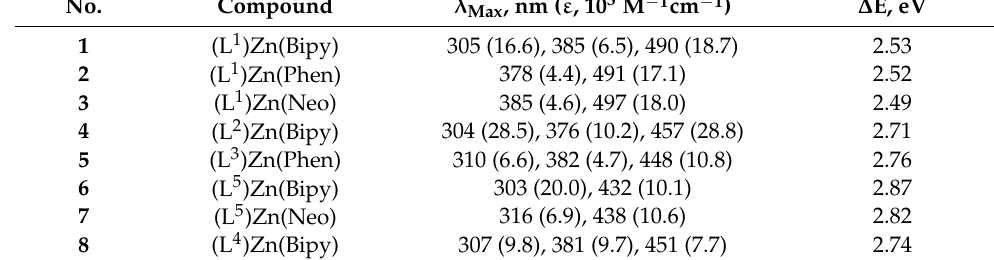
Table 3. The UV-vis spectral data for 1 – 8 in CHCl 3 solution at 293 K.